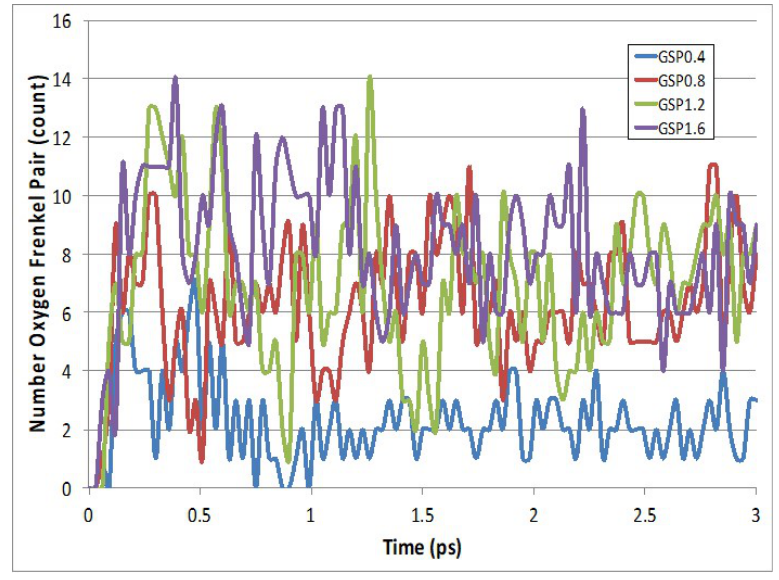
Figure 8. Time change of oxygen Frenkel pairs for gSe = 0.4, 0.8, 1.2, and1.6 keV/nm.